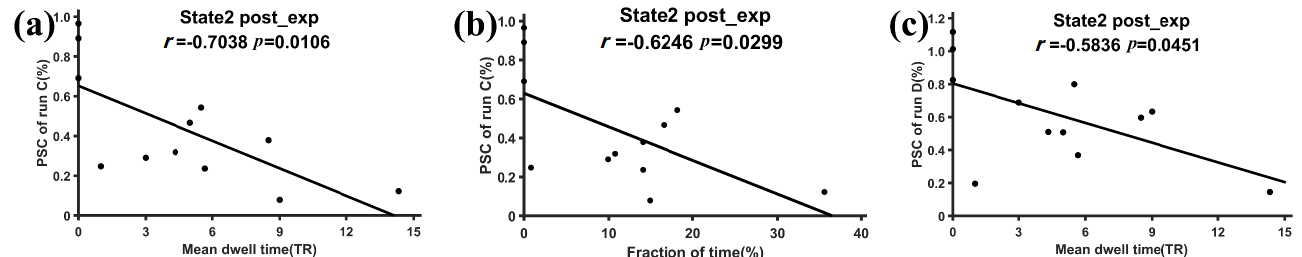
Figure 7. The relationship between the PSC of the neurofeedback runs and DFNC of the post-training run for the experimental group. ( a ) The significant regression relationship between the mean dwell time of state 2 and PSC of run C, ( b ) the significant regression relationship between the fraction time of state 2 and PSC of run C, and ( c ) the significant regression relationship between the mean dwell time of state 2 and PSC of run D.